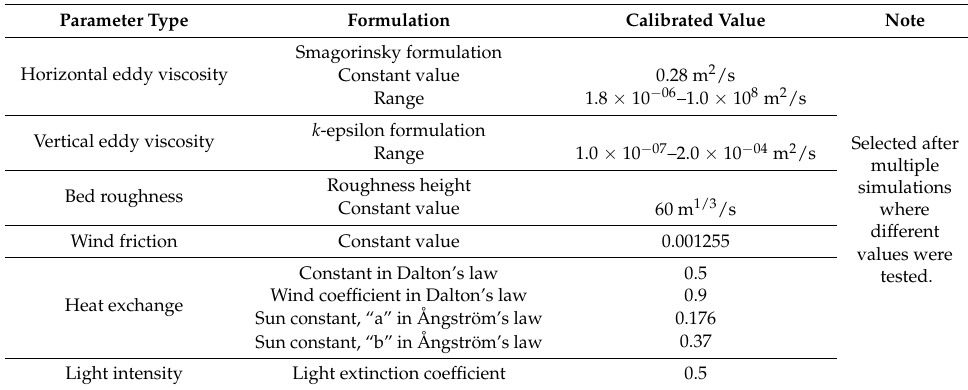
Table 2. Parameter values used in the hydrodynamic